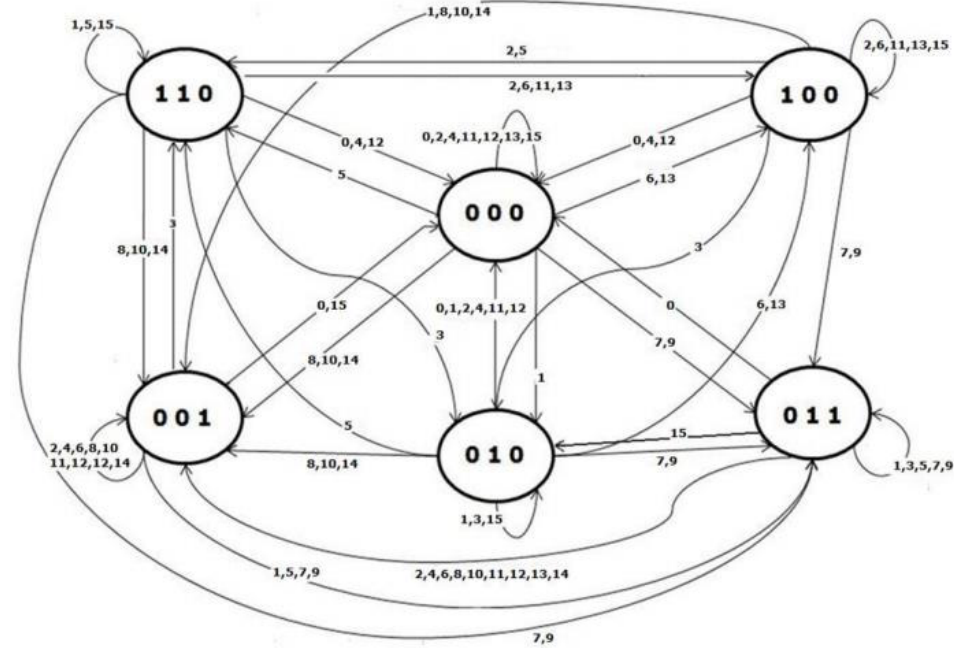
Figure 9. Automata (for the split range of the thermal control) of the initial control system. Table 8. Split range operating modes (thermal control, initial control system).